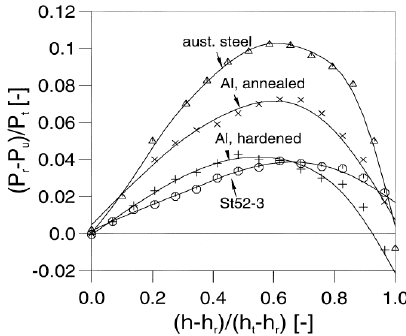
Figure 6. Opening of experimental measured hysteresis loops [22]. Reproduced with permission from N. Huber et al., Mechanics of Materials; published by Elsevier,